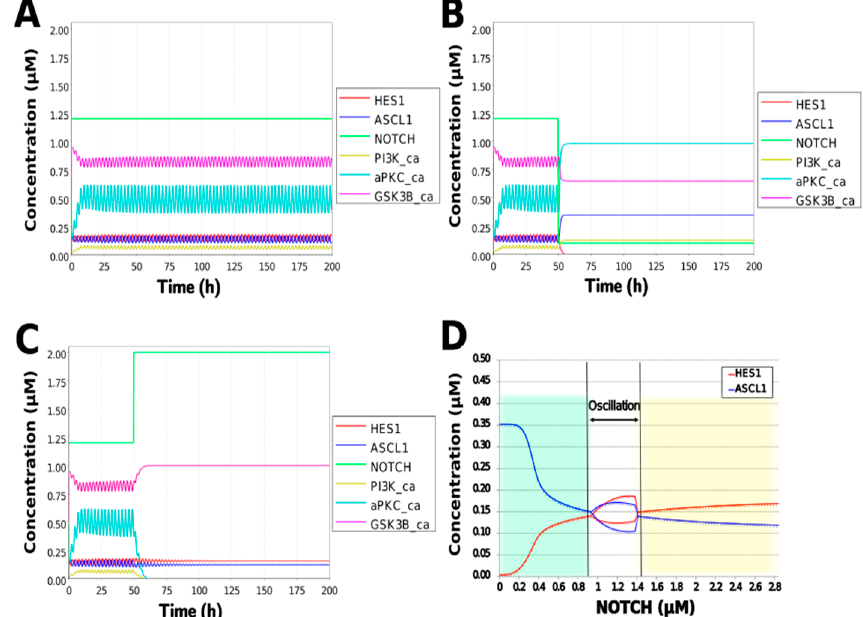
Figure 5. Simulation of the toy model. ( A ) Basic condition with a 2.5 h period. ( B ) Negative and ( C ) positive perturbation of the NOTCH concentration at 50 h. ( D ) Bifurcation analysis of the HES1 and ASCL1 concentration dependence on the NOTCH concentration. Background colors show cell differ ‐ entiation state; green, neuron; yellow, astrocyte. Table 2. Oscillation parameter ranges.